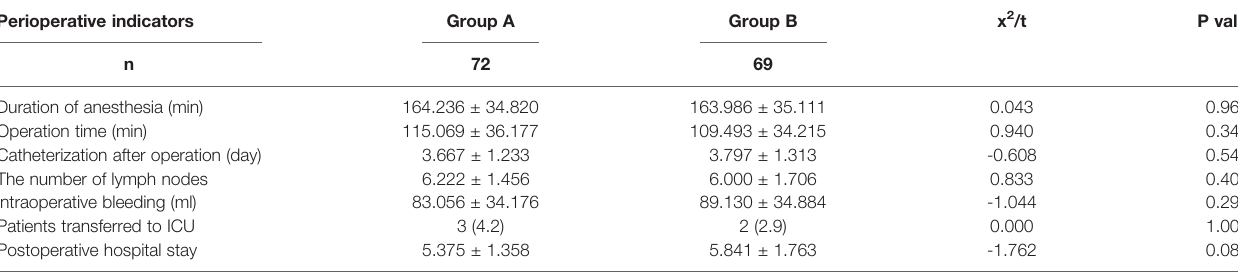
TABLE 2 | Comparison of perioperative conditions between the two